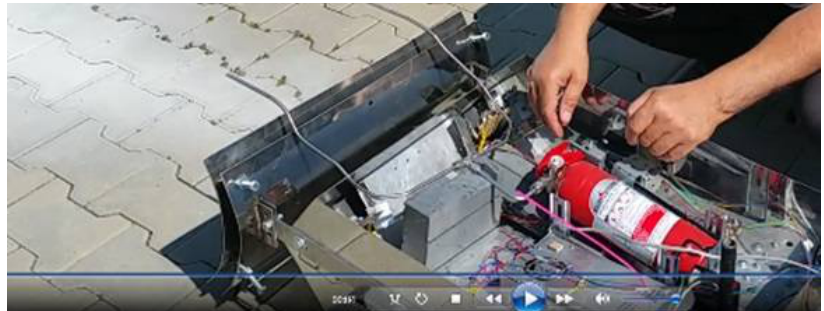
Figure 20. Fire extinguishing system with two fire extinguishers and mechanism for maintaining the pressure of the extinguishing-type powder (Florex, E.12, Carbo, based on KHCO 3 ). After testing the fire extinguishing system, using a fire set with a cloth soaked in diesel, we examined the capacity of the robot to intervene in this scenario, so we list in Figure 21.